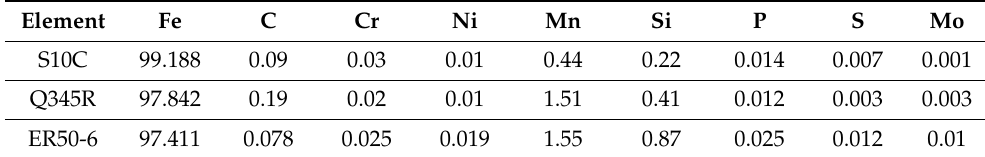
Table 2. Welding parameters (speed:2 mm/s, voltage:14 V). Parameters